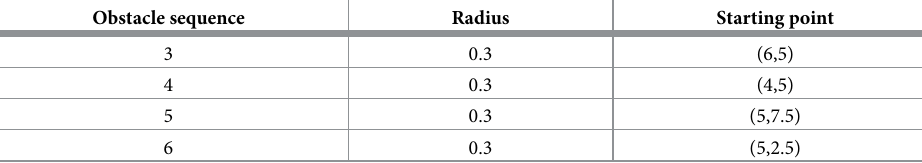
Table 6. The characteristic of nonlinear movement